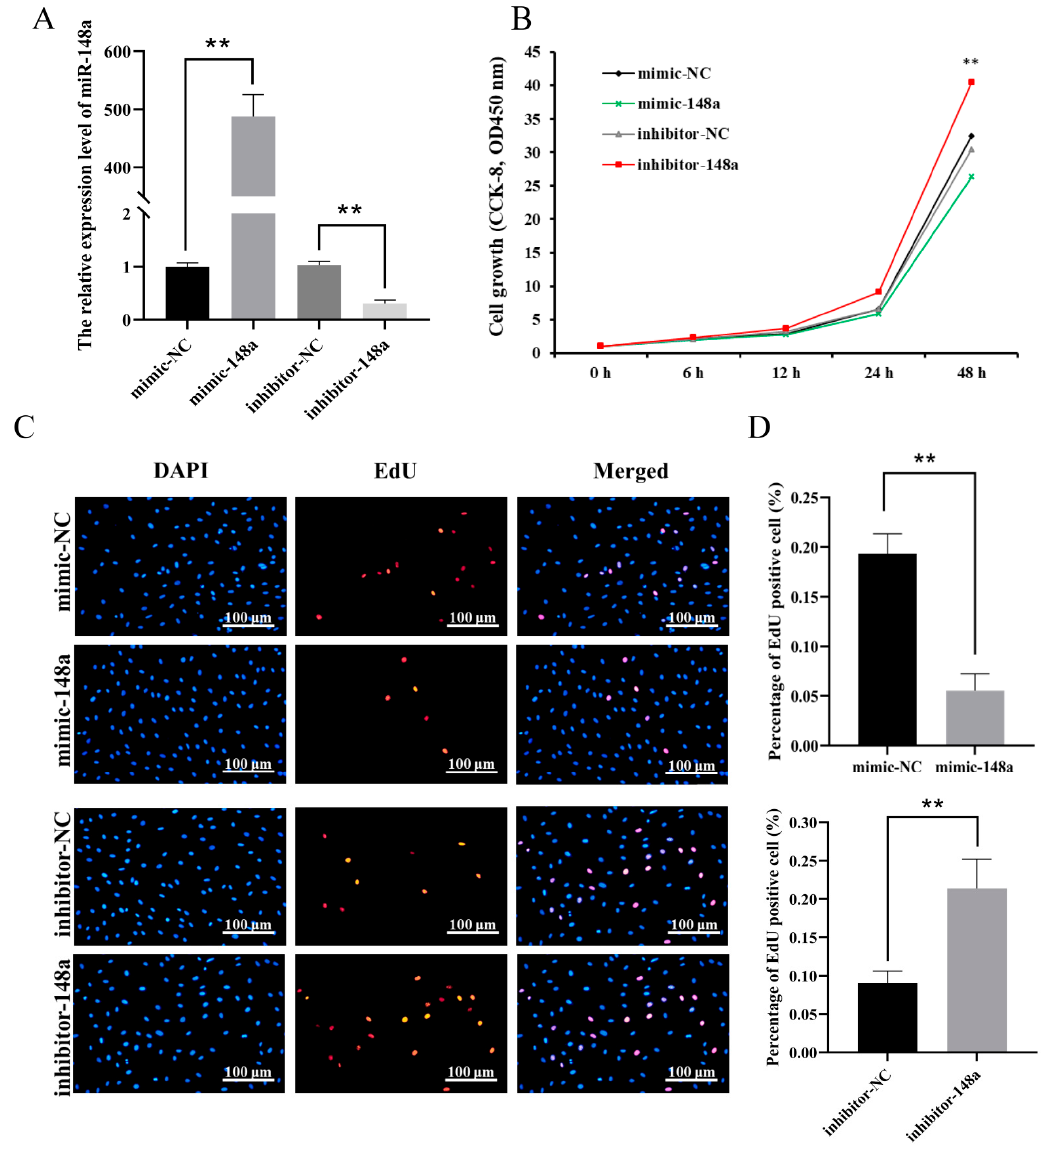
Figure 4. The miR-148a suppressed ovine preadipocyte proliferation. ( A ) The over-expression efficiency of miR-148a at 48 h in ovine preadipocytes after being transfected miR-148a mimic, miR-148a inhibitor and negative control (NC). ( B ) Effects of the miR-148a mimic, miR-148a inhibitor and NC on preadipocyte proliferation using CCK-8. ( C ) EdU was used to detect the effect of the miR-148a mimic, miR-148a inhibitor and NC on preadipocyte proliferation. The images of DAPI, EdU, and Merged groups reflect the total number of preadipocytes, the number of EdU-positive preadipocytes and the proportion of EdU-positive preadipocytes in the total preadipocytes, respectively. ( D ) The statistics of the number of EdU-positive preadipocytes. The results are depicted as the mean ± SD ( n = 3), ** p < 0.01.